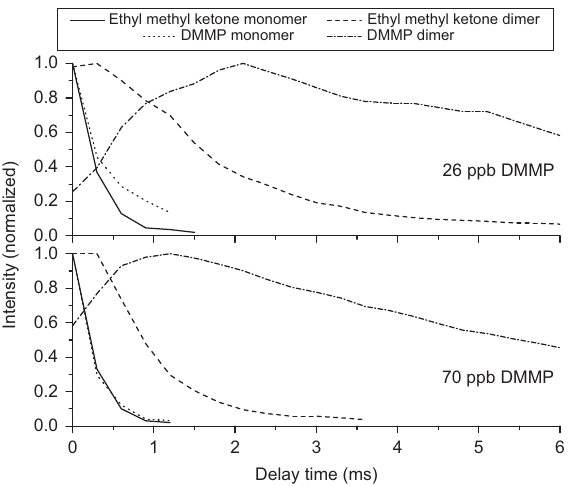
Figure 6 Dimer and monomer signals decay differently in mixtures, here shown for DMMP and ethyl methyl ketone (concentration 110 ppb). The dimer signals decay much more slowly, and the dimer of the substance with the higher proton affinity (DMMP) decays most slowly even if its concentration is low compared to the other substance ’ s